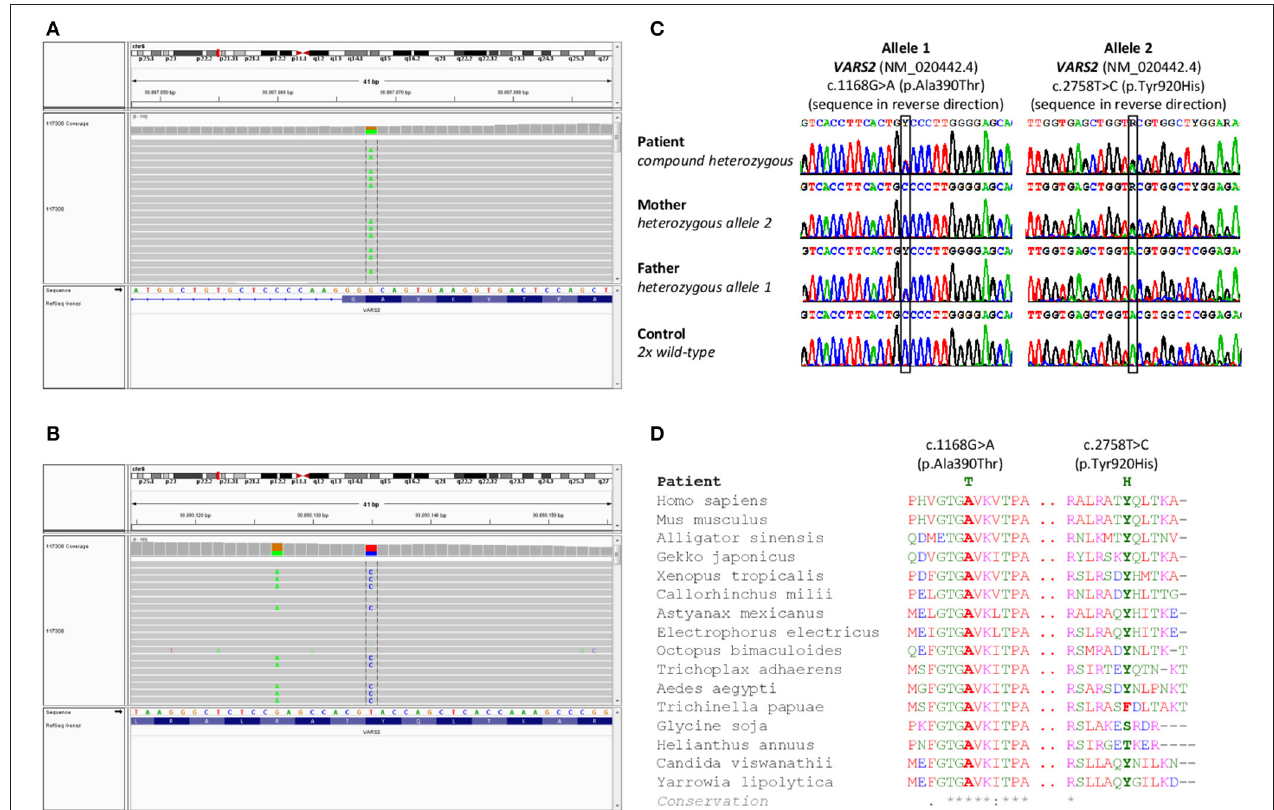
FIGURE 1 | Results of genetic testing. (A,B) Whole exome sequencing results in a patient with a finding of biallelic variants in the VARS2 gene, heterozygous variant c.2758T > C (p.Tyr920His) and heterozygous variant c.1168G > A (p.Ala390Thr) . (C) Sanger sequencing confirmed both variants in the patient. Heterozygous variant c.2758T > C (p.Tyr920His) was found in patient’s mother and heterozygous variant c.1168G > A (p.Ala390Thr) was found in patient’s father. These findings confirmed biallelic position of variants in the patient, (D) shows phylogenetic conservation of VARS2 protein (NP 065175.4) in various organisms. Multiple sequence alignment was performed with Clustal Omega (https://www.ebi.ac.uk/Tools/msa/clustalo/).